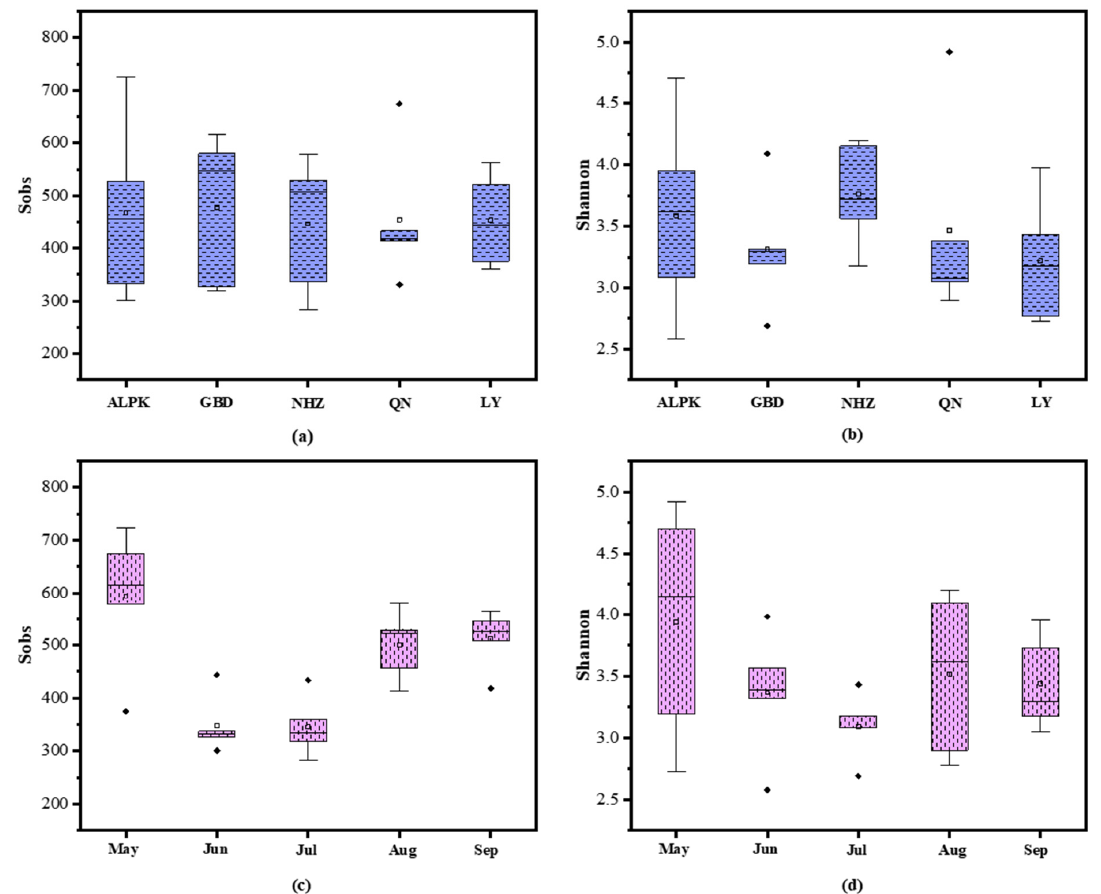
Figure 2. OTU richness (Sobs) and diversity (Shannon) of all samples in different locations ( a , b ) and different months ( c , d ).